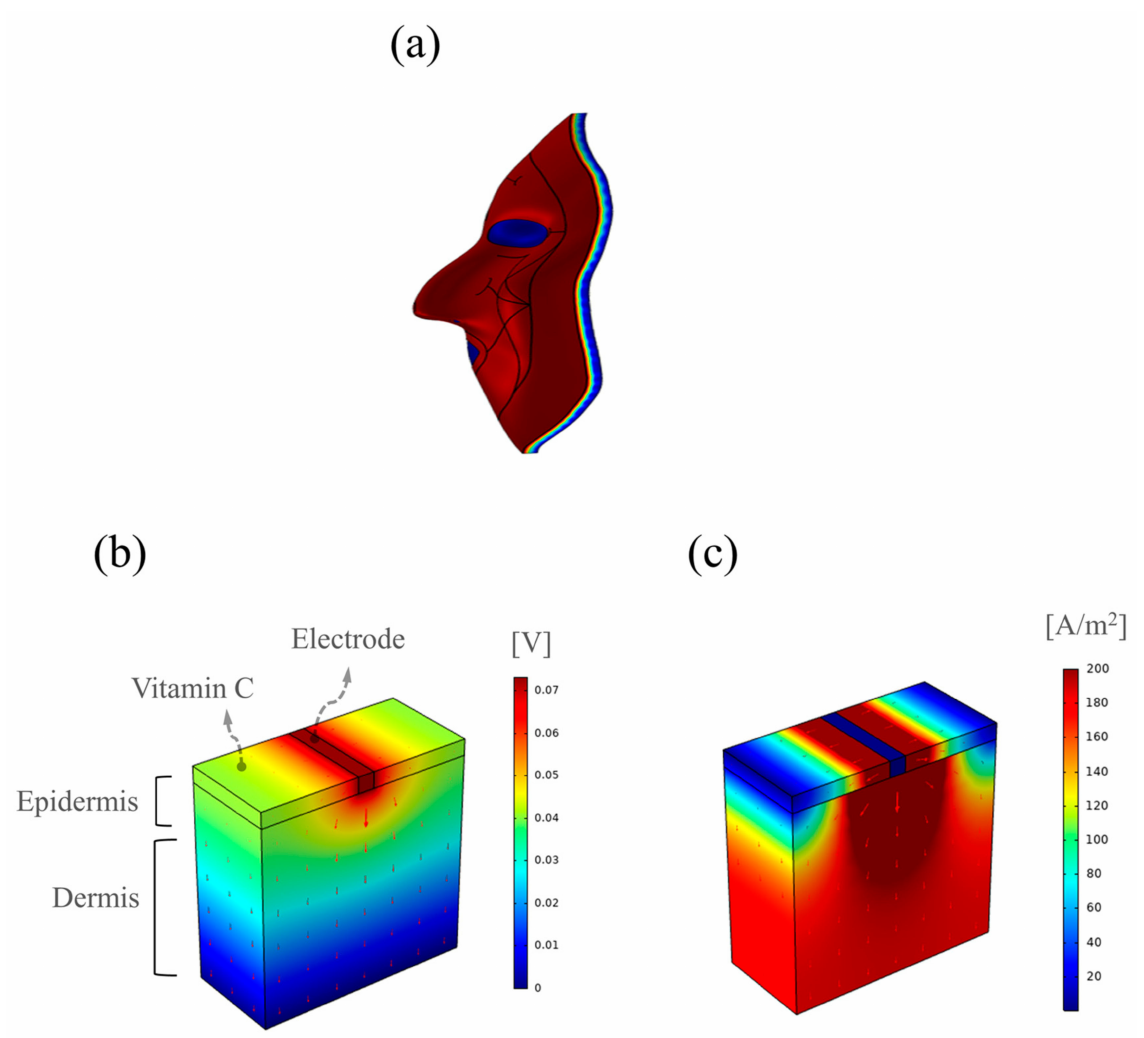
Figure 8. Numerical simulation of the application of the electrically assisted facial mask. ( a ) Expected drug delivery on facial mask skin, ( b ) electrical potential (red arrows: direction of electric field), and ( c ) normalized current density (red arrows: direction of current density). Figure 8b,c present the distributions of the electric potential and normalized current density on the skin when a current of 100 µ A was applied to the electrode,